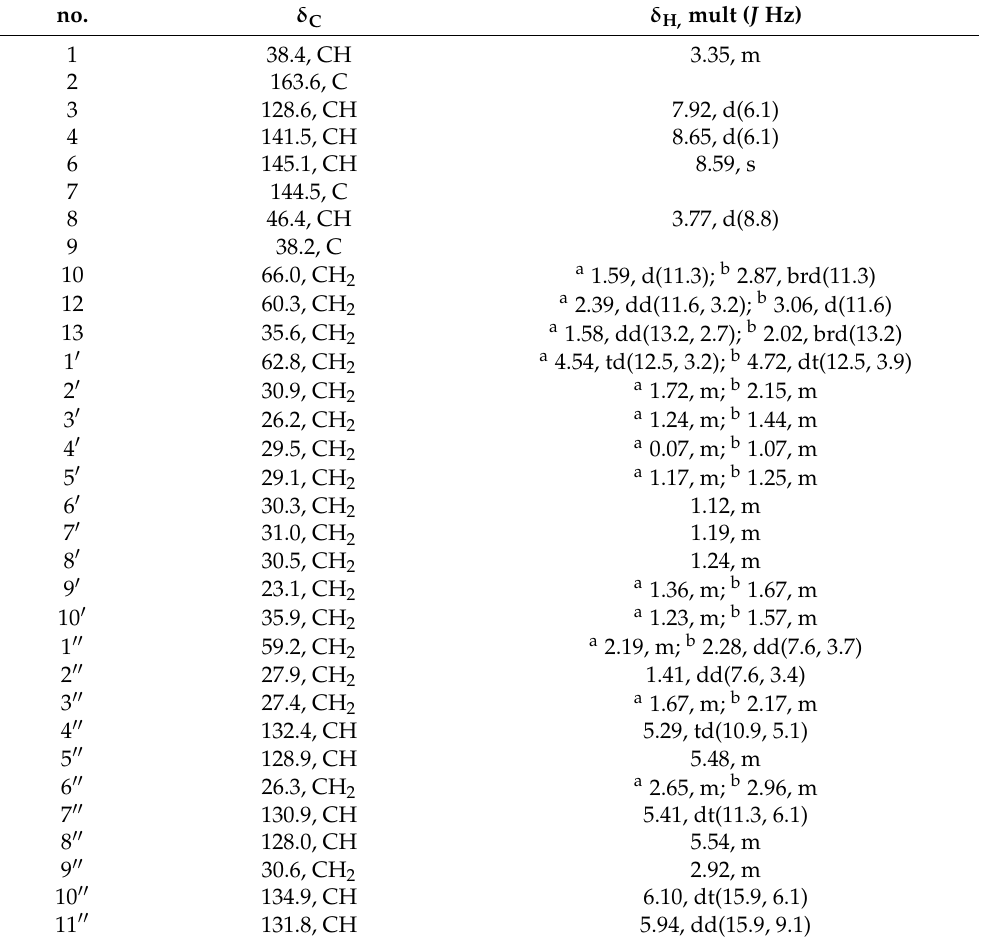
Table 1. 1 H (500 MHz) and 13 C NMR (125 MHz) data for compound 1 in CD 3 OD ( δ in ppm, J values in parentheses).